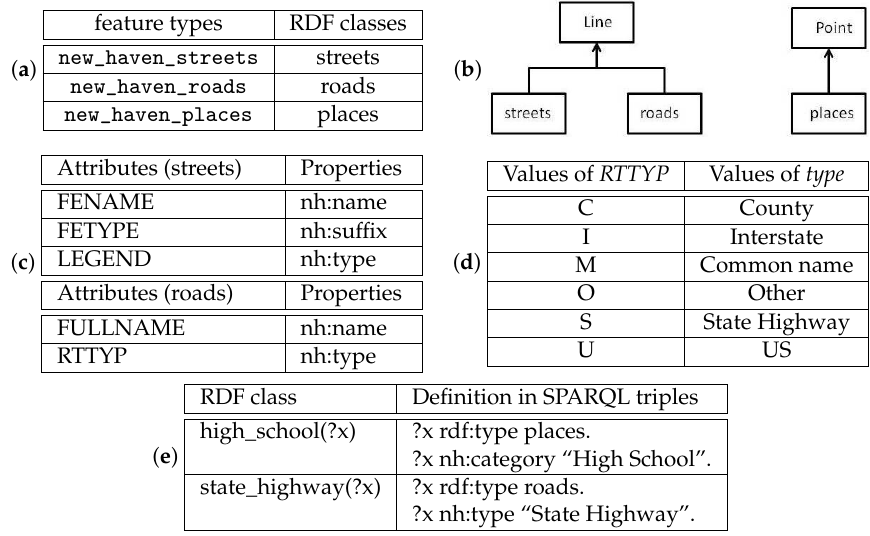
Figure 1. ( a ) mapping of feature types, ( b ) ontology class hierarchy, ( c ) mapping of attributes of roads and streets, ( d ) mapping of the values of RTTYP , ( e ) definition of RDF class high_school and